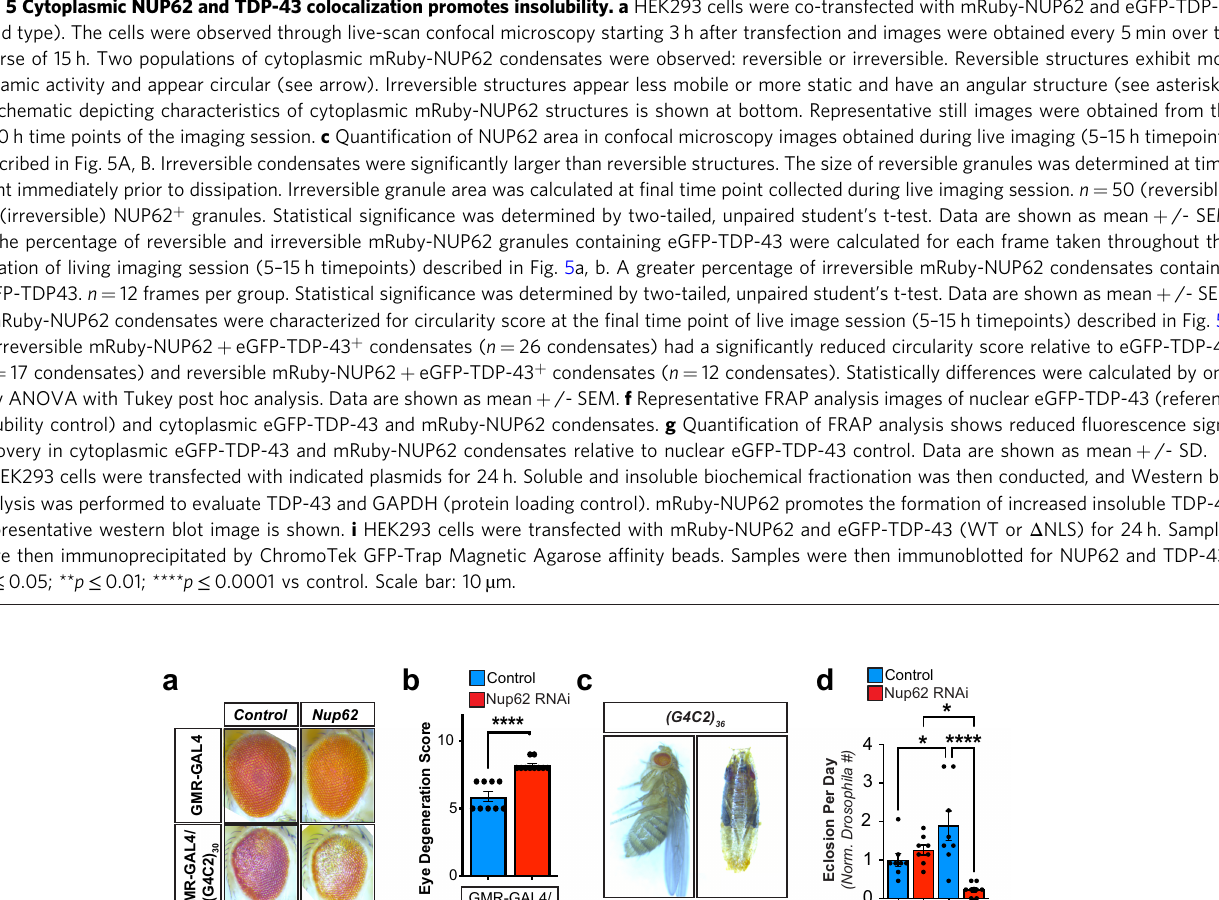
Fig. 6 Nup62 is a genetic modi fi er of C9-ALS/FTD Drosophila models. a Representative images of fl y eyes from GMR-GAL4 wild-type (top row) or (G4C2) 30 repeat expansion (bottom row) fl ies combined with control (eGFP) or UAS-Nup62 RNAi fl ies. b Quanti fi cation of scored fl y eye degeneration. Nup62 RNAi signi fi cantly enhances retinal degeneration of (G4C2) 30 repeat expansion. Symbols are indicative of eye degeneration score for individual fl ies evaluated. n = 9 (control) or 10 (Nup62 RNAi) fl ies. Statistically signi fi cant differences were calculated by unpaired, two-tailed t-test: **** p ≤ 0.0001. Data are shown as mean + /- SEM. c Combination GMR-GAL4; (G4C2) 36 repeat expansion were crossed with a UAS-Nup62 RNAi or UAS-eGFP fl y. Shown are representative images of these fl ies 0 – 1 day post eclosion. d Bar graph shows the normalized quanti fi cation for (G4C2) 36 repeat expansion fl y eclosion in the presence and absence of Nup62 RNAi. The bars show average eclosion per day over the course of 8 days while individual dots are representative of fl y counts for one 24 h eclosion period. (G4C2) 36 ;GMR-GAL4 line crossed with UAS-eGFP fl y line was used as the control group. Samples sizes n = 8 fl ies per group. Statistically signi fi cant differences in eclosion frequency were determined by one-way ANOVA with Tukey ’ s multiple comparison ’ s test: * p ≤ 0.05, **** p ≤ 0.0001. Data are shown as mean + /- SEM. e Combination GMR-GAL4/TM3; Nup62 OE/Sb were crossed with UAS-(G4C2) 36 fl ies. Representative images are of fl ies carrying Nup62 overexpression or internal controls from the same cross carrying the Sb phenotype instead of Nup62 overexpression. Resulting progeny were evaluated within 24 h of eclosion. W1118 phenotype Drosophila were used as control. f Degeneration of fl y eye was scored according to previously described methods 110 . We fi nd Nup62 overexpression abolishes the (G4C2) 36 repeat expansion fl y eye degeneration ( n = 4 fl ies per group). Statistically signi fi cant differences were calculated by unpaired, two-tailed t-test: **** p ≤ 0.0001. Data are shown as mean + /- SEM. g Representative images of retinal degeneration in the presence and absence of Nup62 knockdown with GR 36 Drosophila . h Retinal degeneration was measured in GR 36 Drosophila with and without Nup62 RNAi. Individual symbols are indicative of individual fl ies and the average degeneration score is presented by the bars. Sample size: n = 10 fl ies per group. Statistically signi fi cant differences were calculated by unpaired, two-tailed t-test. **** p ≤ 0.0001. Data are shown as mean + /-